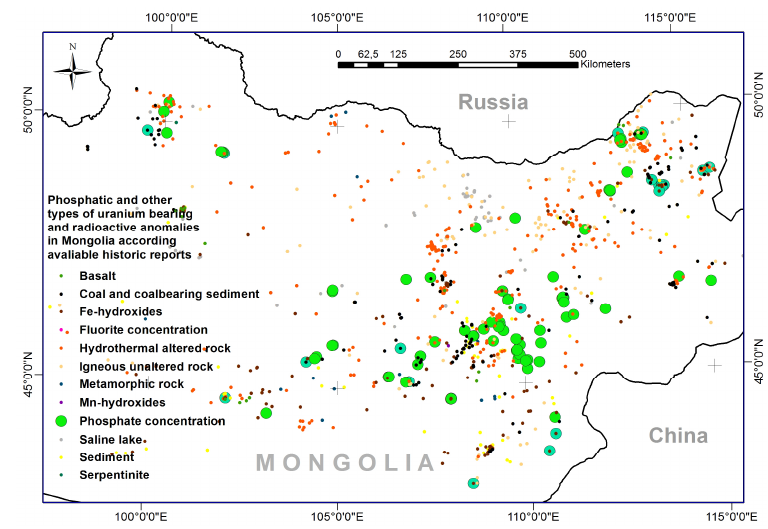
Figure 1. Schematic map of East Mongolia with historical uranium-phosphate bearing anomalies (green dots).